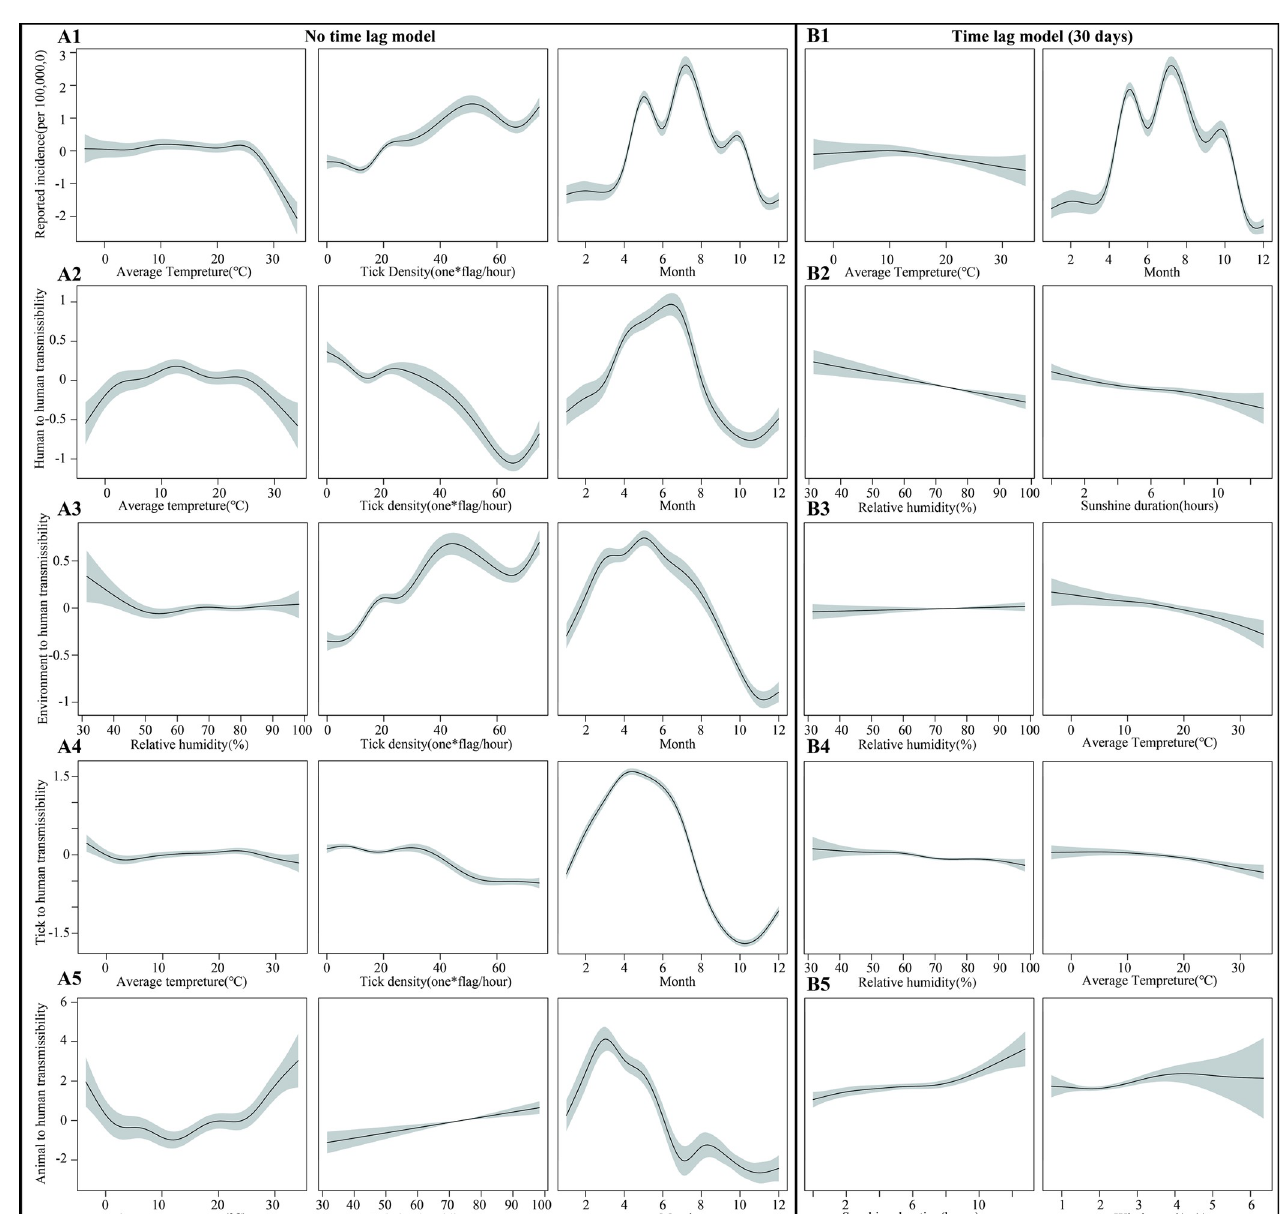
Fig 6. Non-linear relationship between SFTS incidence and different transmissibility with meteorological factors and tick density in Jiangsu Province. Part A: SFTS incidence and different infection coefficients with meteorological factors and tick density in no time lag GAM; A1: Plots of non-linear relationship with factors associated with reported incidence; A2: Plot of non-linear relationship with factors associated with the infection coefficient of human- to-human; A3: Plot of non-linear relationship with factors associated with the infection coefficient of environment-to-human; A4: Plot of non-linear relationship with factors associated with the infection coefficient of tick-to-human; A5: Plot of non-linear relationship with factors associated with the infection coefficient of animal-to-human. Part B: SFTS incidence and different infection coefficients with meteorological factors and tick density in time lag GAM; B1: Plots of non-linear relationship with factors associated with reported incidence; B2: Plot of non-linear relationship with factors associated with the infection coefficient of human-to-human; B3: Plot of non-linear relationship with factors associated with the infection coefficient of environment-to-human; B4: Plot of non-linear relationship with factors associated with the infection coefficient of tick-to-human; B5: Plot of non-linear relationship with factors associated with the infection coefficient of animal-to-human).